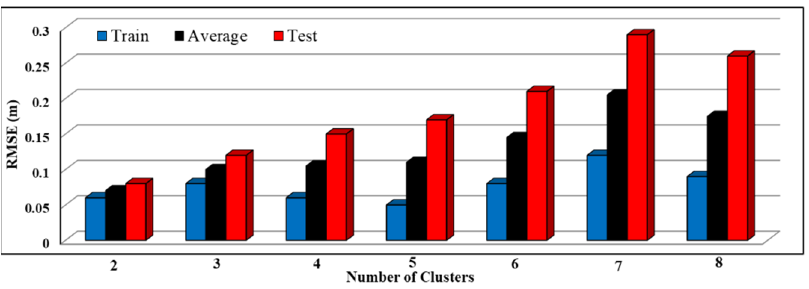
Figure 7. The values of RMSE for different number of clusters in the FCM method.